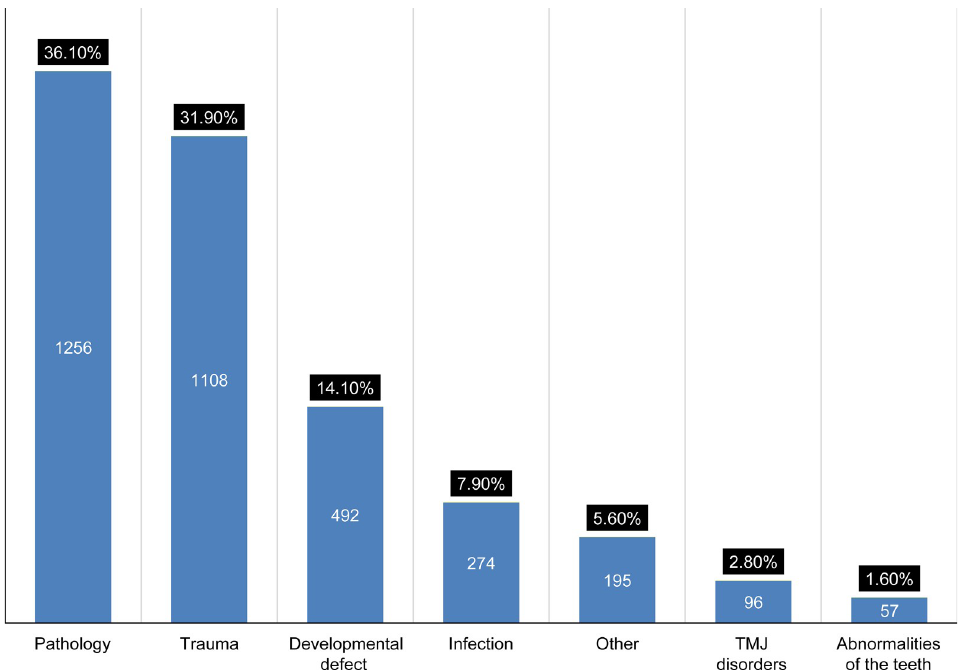
Fig 1. Distribution (number and percentage) of the diagnosis